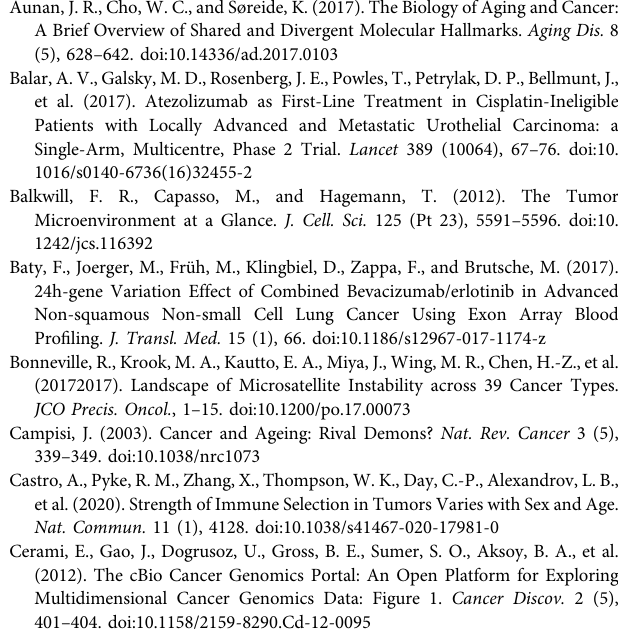
Supplementary Figure S1 | PPI network of SRGs. The PPI network was constructed using STRING website. Supplementary Figure S2 | Correlation between the 33 SRGs ’ expression and immune in fi ltrating subtypes of 33 cancer types. Blue represents positive correlations and red represents negative correlations (Spearman correlation, p < 0.05 was considered signi fi cant, * p < 0.05; ** p < 0.01; *** p < 0.001). Supplementary Figure S3 | Correlation of 33 SRGs ’ expression with drug sensitivity in cancers. (A) Correlation between drug sensitivity of GDSC and SRGs ’ expression. (B) Correlation between drug sensitivity of CTRP and SRGs ’ expression. The negative correlation indicates that the gene ’ s high expression is sensitive to the drug and vice versa. Blue bubbles represent negative correlations; red bubbles represent positive correlations. The deeper the color, the higher the correlation. Bubble size is positively correlated with the FDR signi fi cance. The black outline border indicates FDR ≤